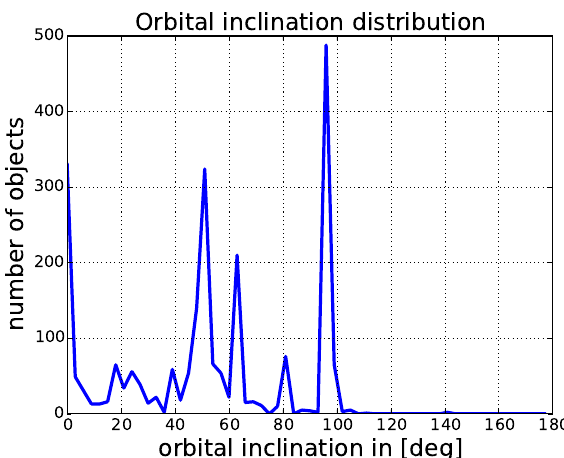
Figure 1. Orbital inclination distribution.